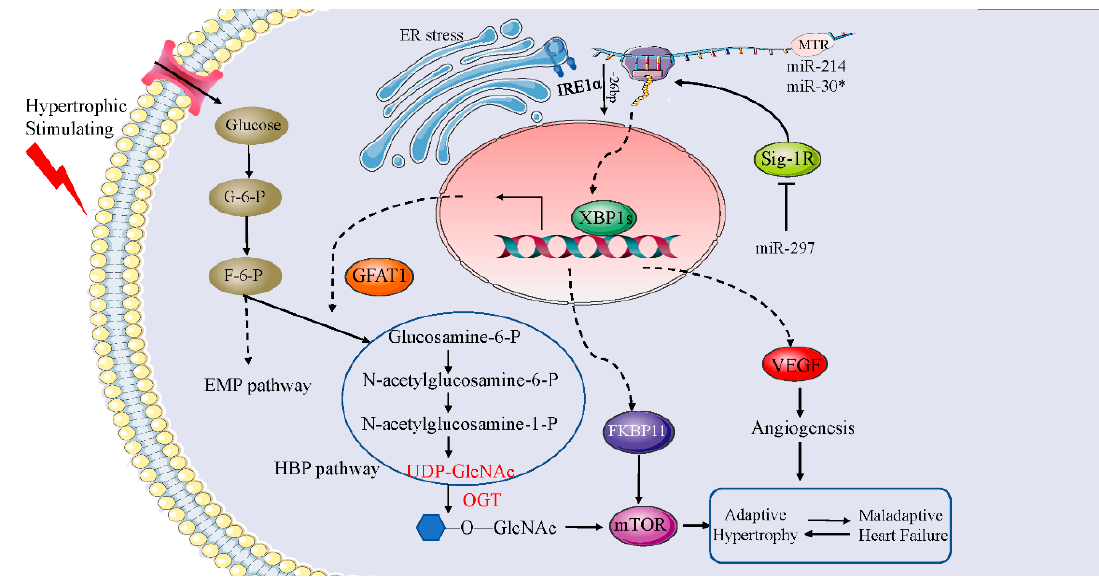
Figure 4. Schematic representation of the critical molecular mechanism of XBP1s in cardiac hyper- trophy. XBP1s is a direct upstream transcriptional activator of multiple enzymes in HBP, one of which is called GFAT1. Under the action of GFAT1, glucose metabolism is shifted to the hexosamine biosynthesis pathway, thereby participating in the pathological process of cardiac hypertrophy through the mTOR pathway. Likewise, a unique transcriptional target of XBP1s, FKBP11 is involved in the mTOR pathway. MiR-297 upregulates the activation of XBP1s signaling by inhibiting the ex- pression of the sigma-1 receptor (Sig-1R), thereby promoting cardiac hypertrophy. miR-30* and miR-214 target XBP1s to synergistically regulate cardiac VEGF production and angiogenesis. GFAT1: glutamine: fructose-6-phosphate amidotransferase 1; FKBP11: fk506-binding protein 11; miR-30*: miR-30 family.